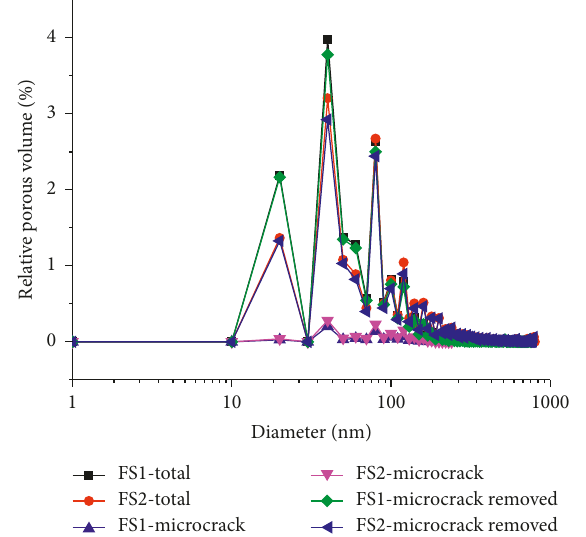
Figure 16: Influence of microcracks on pore size distribution of FIB/SEM